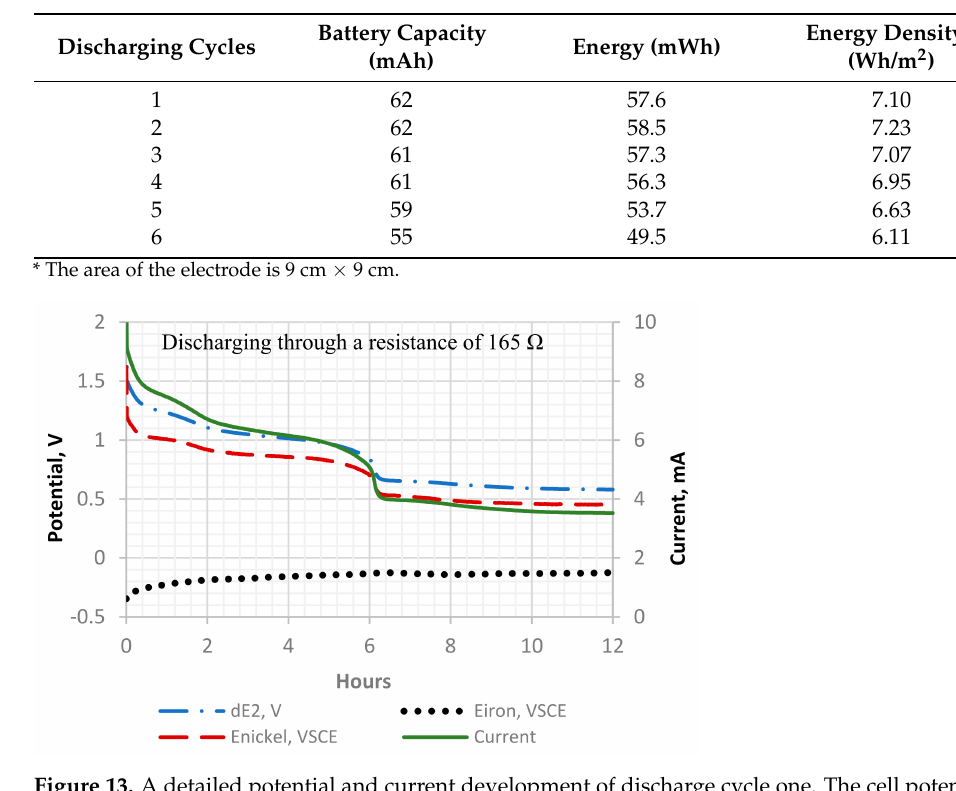
Table 13. Battery performance of Ni-Fe concrete battery. Each discharge cycle is 12 h.